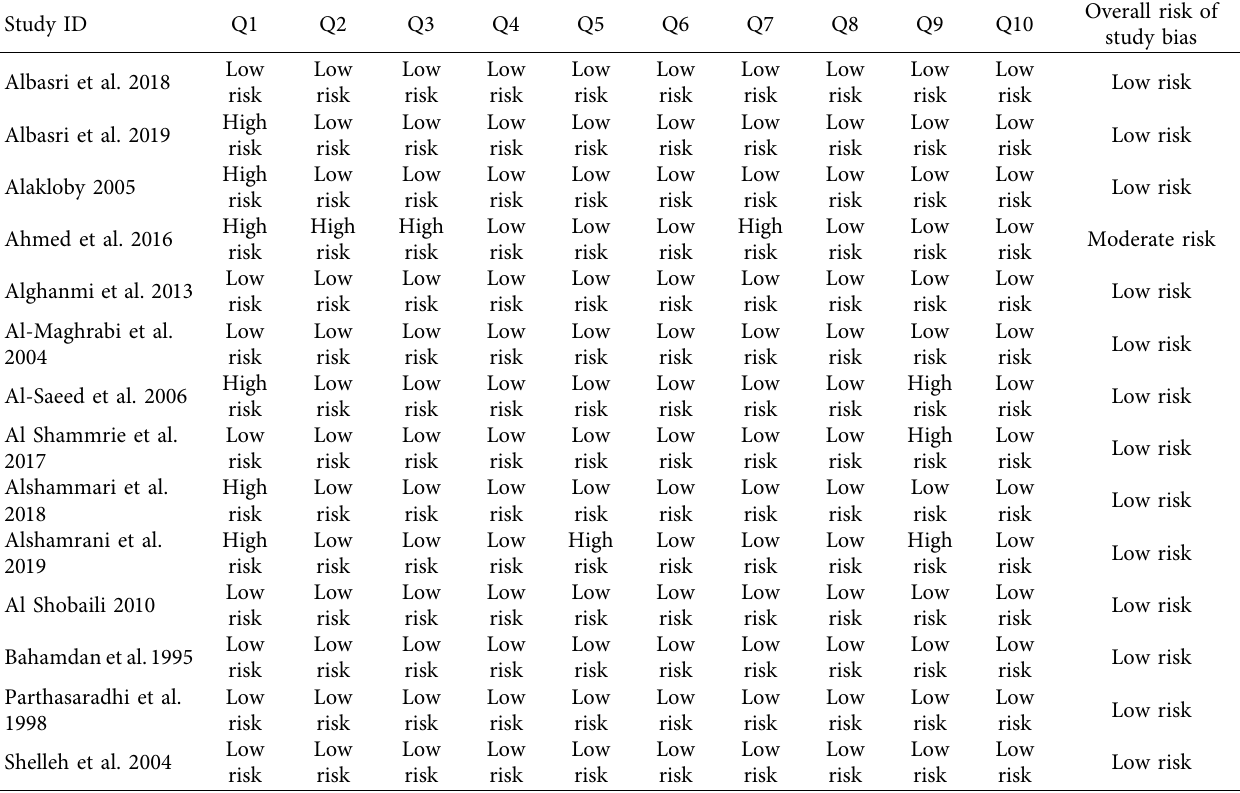
Table 2: Evaluation of the risk of bias in included primary